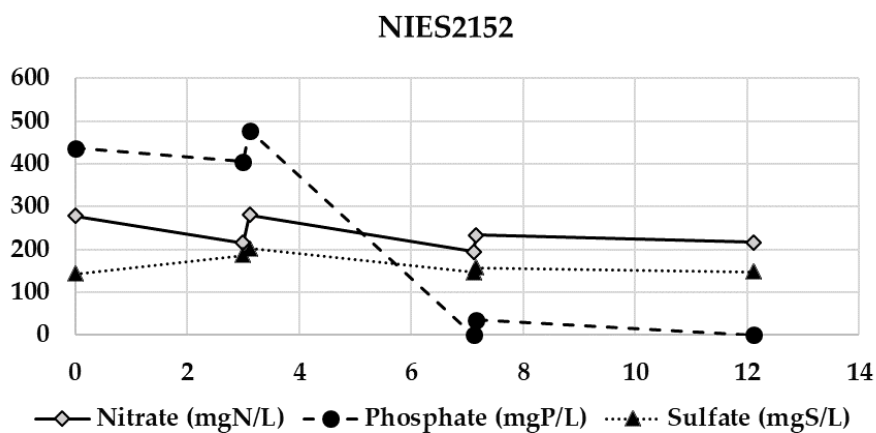
Figure A3. Evolution of the nitrate, phosphate, and sulfate concentrations during the semi-continuous test for NIES2152.